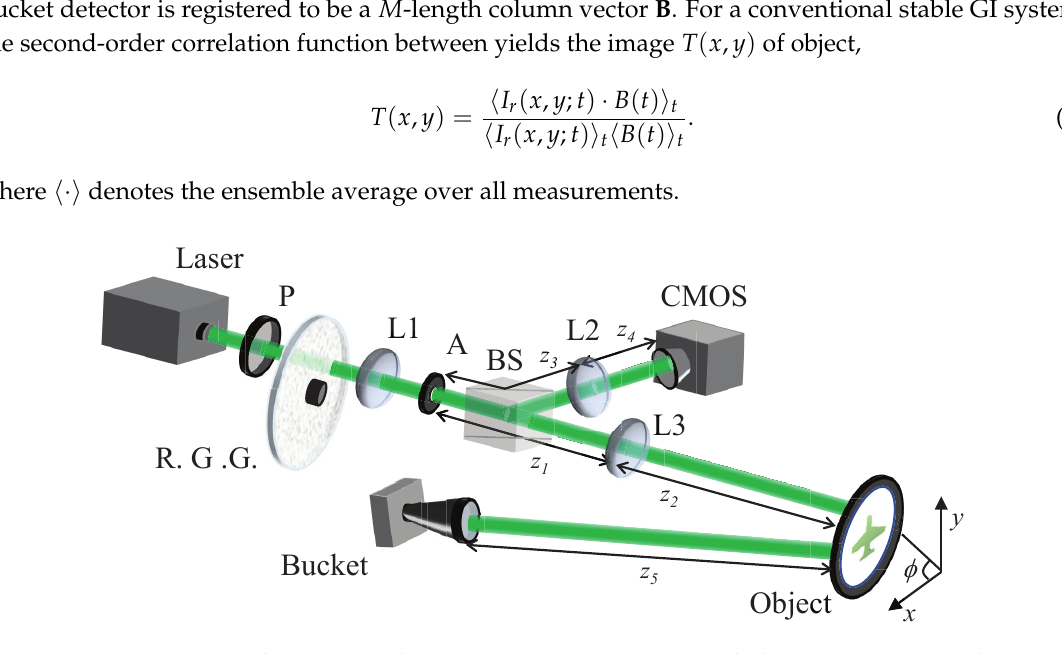
Figure 1. Experimental setup. P: Polarizer; R. G. G.: Rotating ground glass; A: aperture; BS: beam splitter; L1, L2, L3: